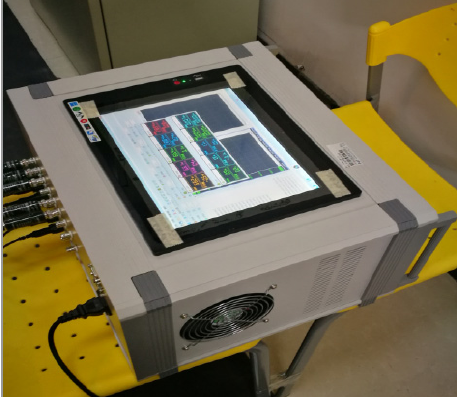
Figure 6. PQM16-D traction substation power quality monitoring system.